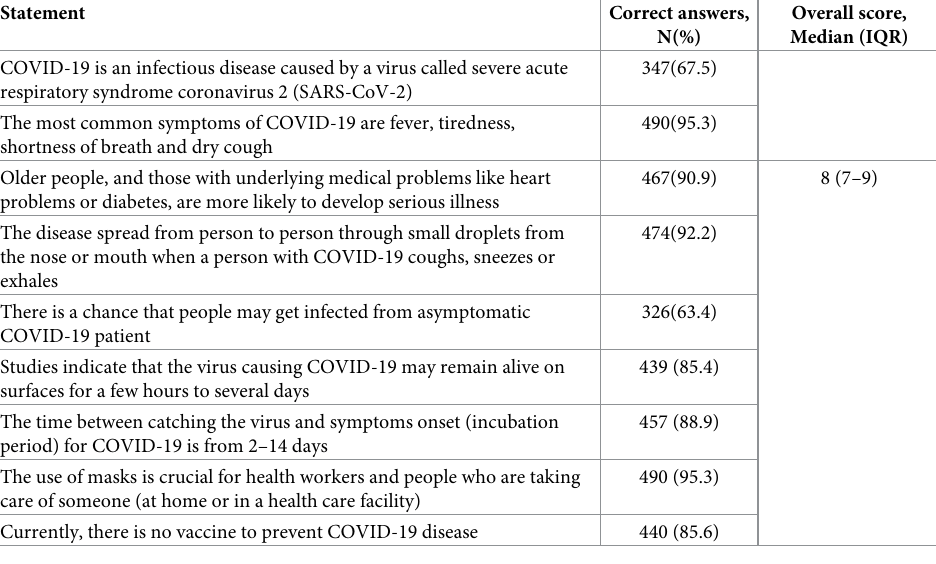
Table 2. Knowledge of the HCWs about the COVID-19